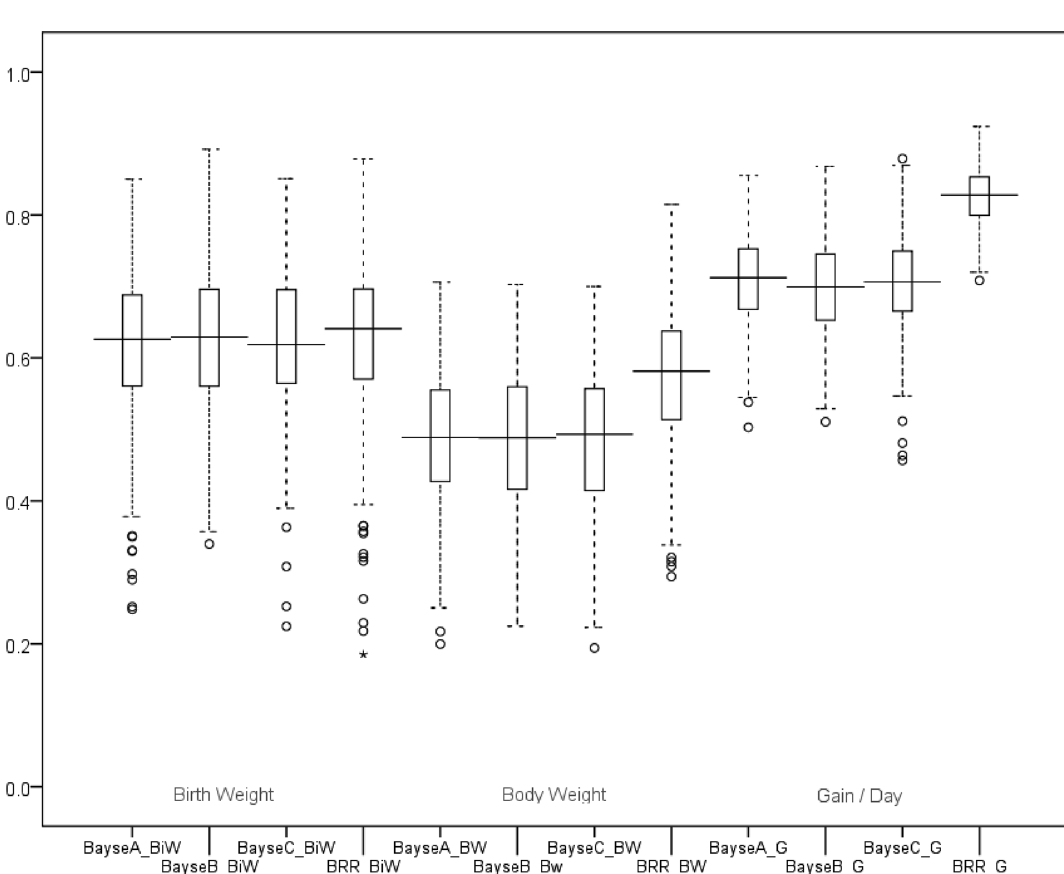
Figure 8. The accuracy of predicted GEBVs from the 99 SNPs using BGLR